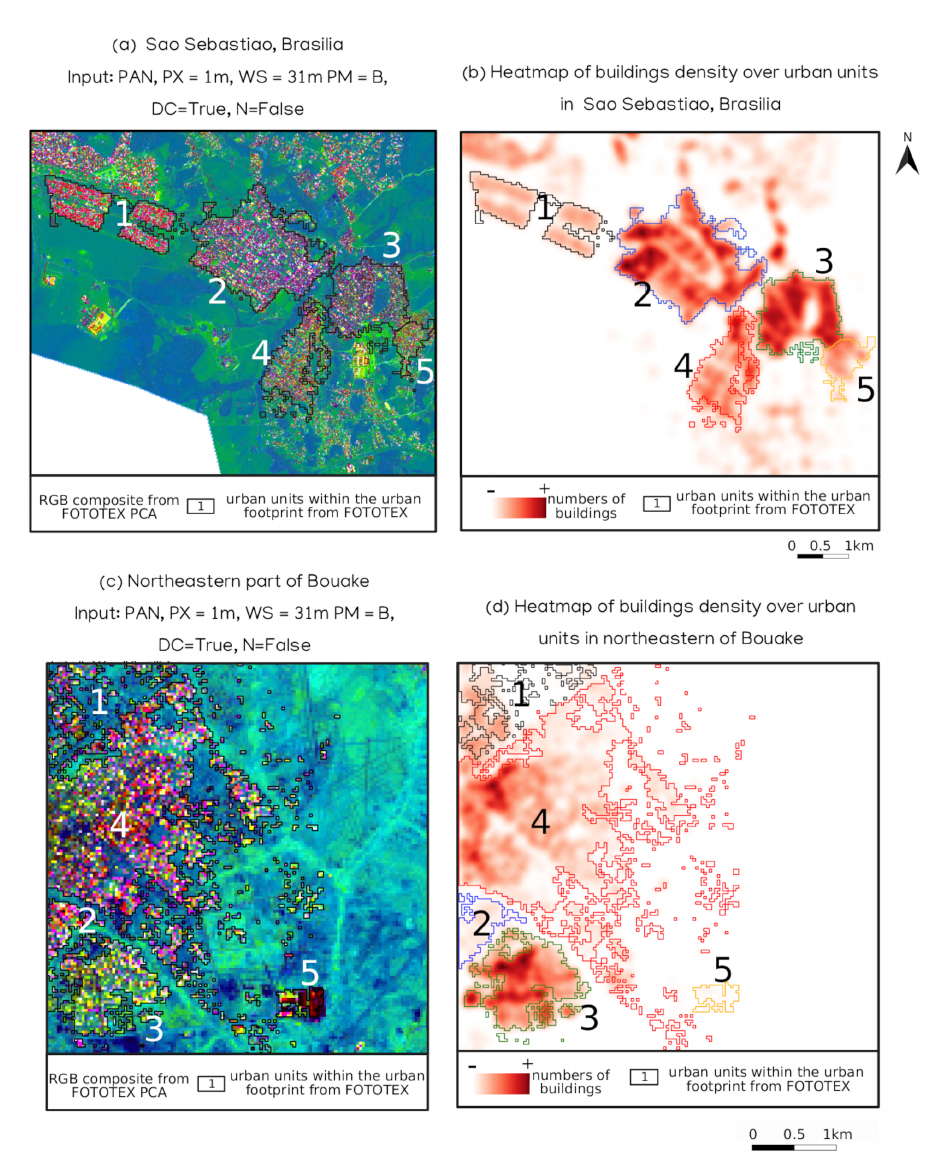
Figure 10. Study of the relationship between texture information at the meso-scale extracted using FOTOTEX on Pleiades images on Sao Sebastiao, Brasilia ( a ) and the northeastern part of Bouake ( c ), with the density of buildings represented as heatmaps using building contours from the SEDUH database (http://www.seduh.df.gov.br/ accessed on 20 September 2020) for Brasilia ( b ) and Open- StreetMap for Bouake ( d ). On this figure, black/colored lines and numbers are urban units extracted from the combination of texture and contours from the urban footprint produced with FOTOTEX and Sentinel